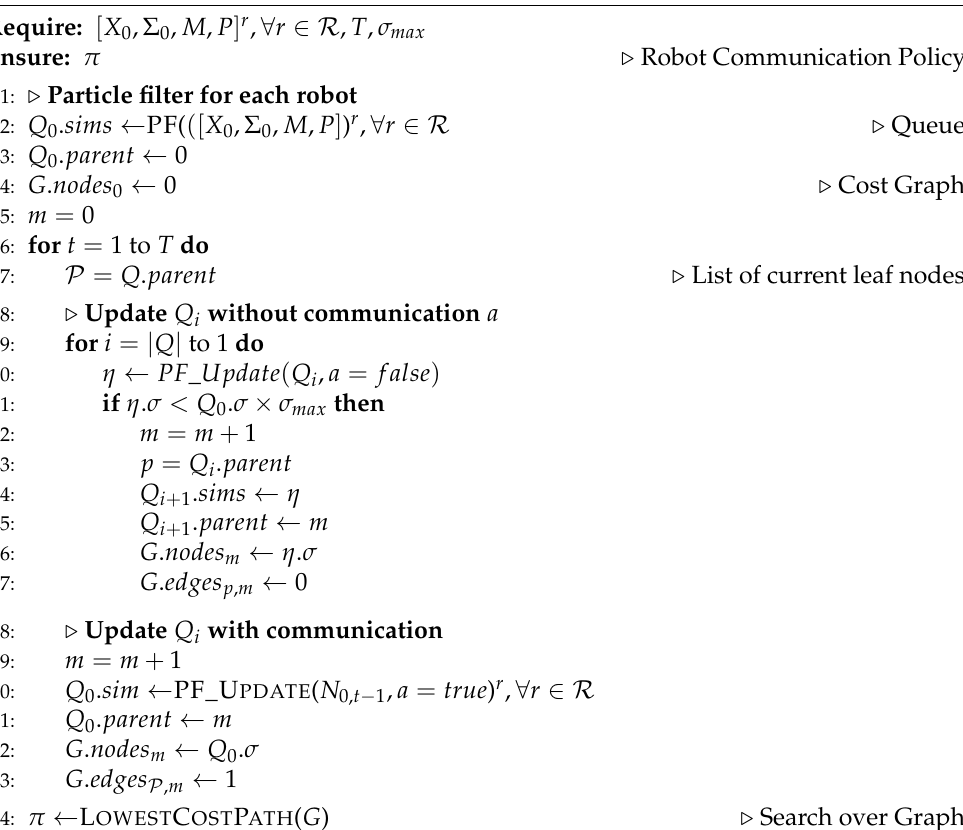
Algorithm 1 Communication Planning